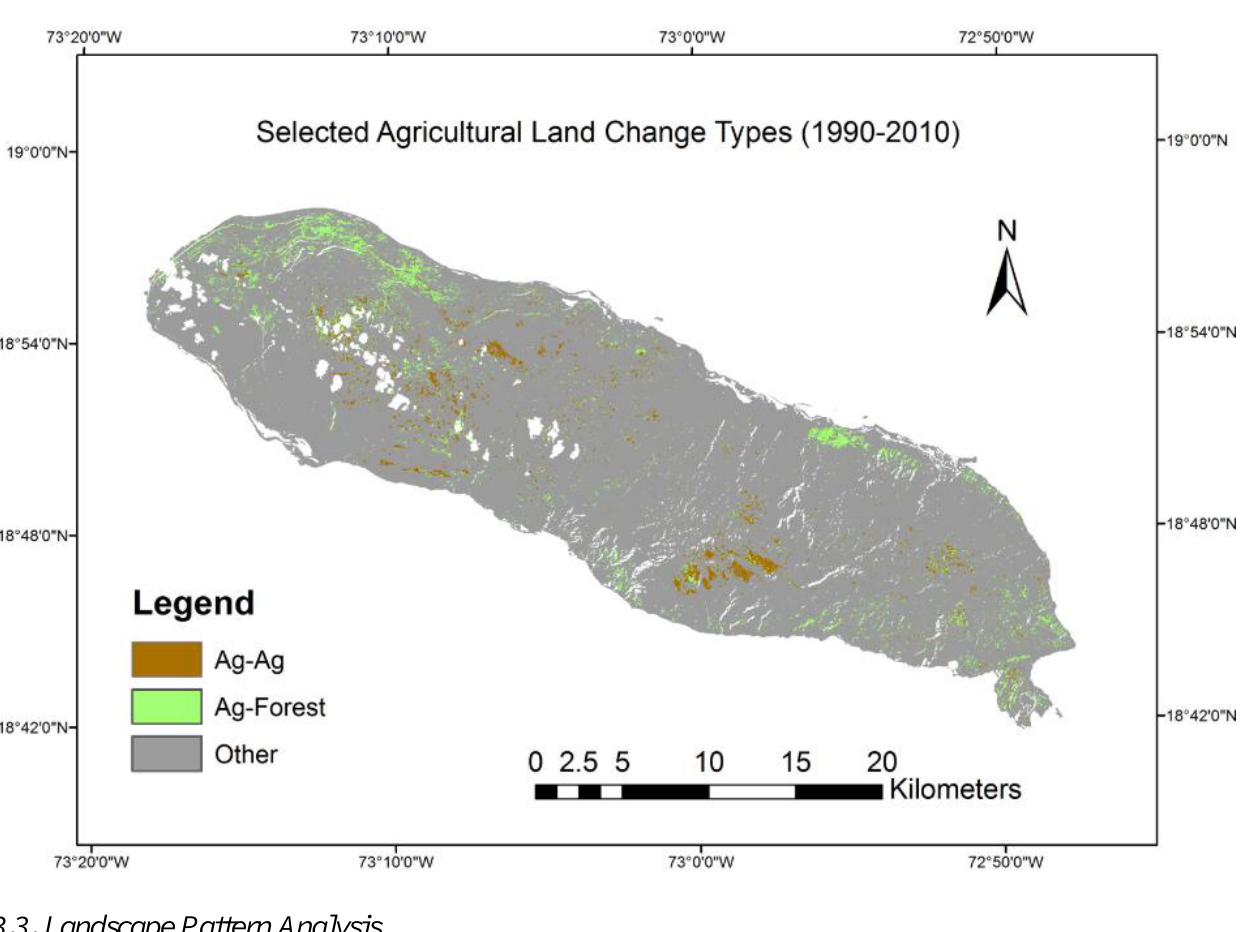
Figure 3. Agricultural areas converted to Forest/Dense Vegetation (DV). The most noticeable agricultural abandonment can be seen in the northwestern corner of La